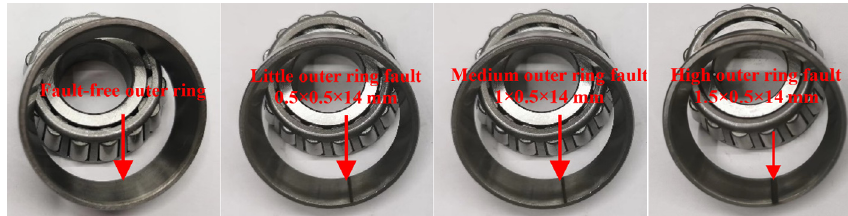
Figure 3. Faulty bearing on the outer ring. Table 3. Details for the defected bearings in artificial damage.